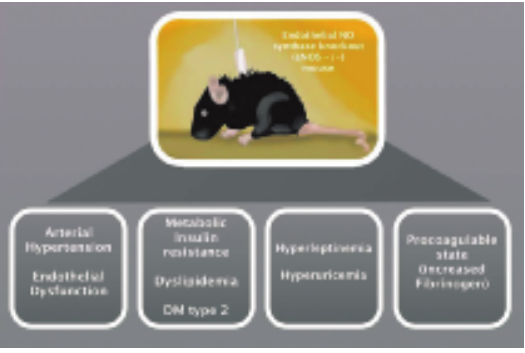
NOS Polymorphism and association with insulin resistance and